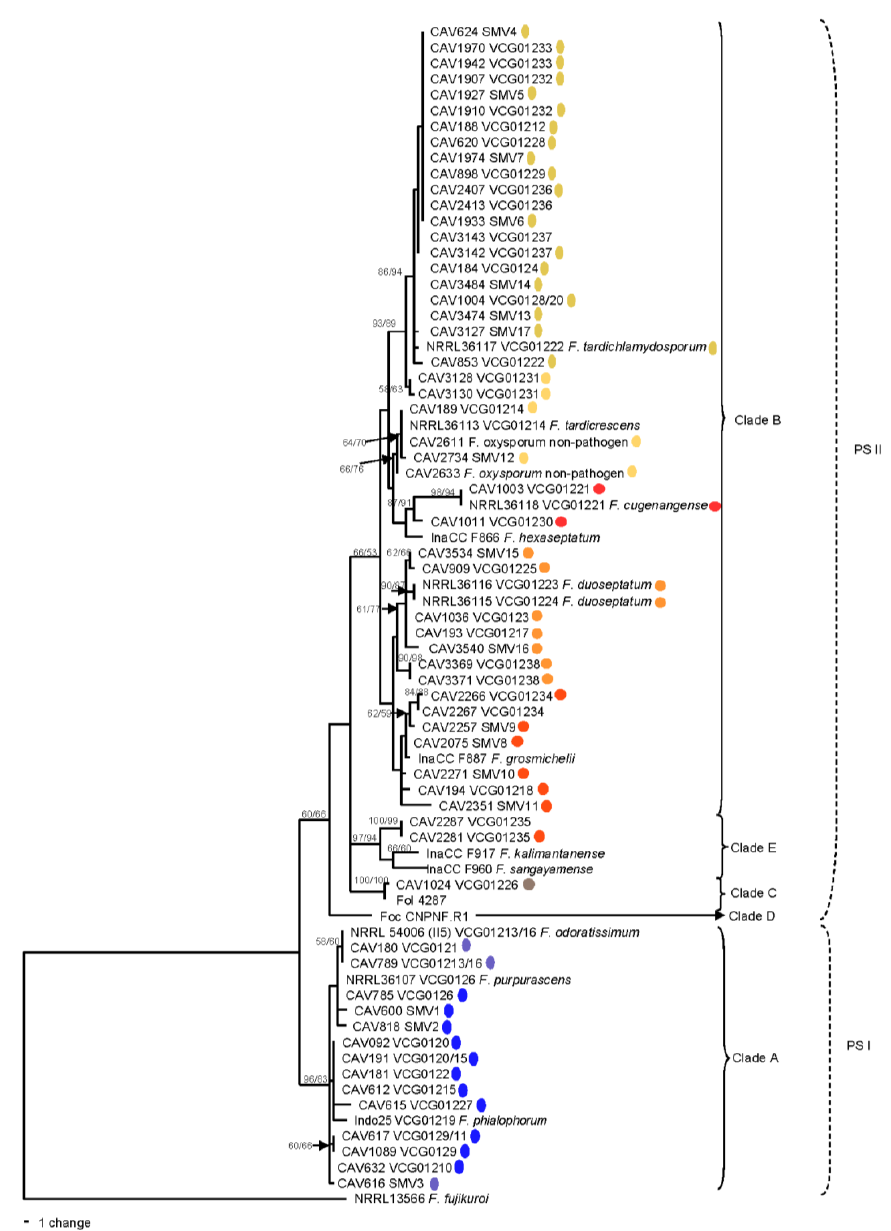
Figure 1. Maximum parsimony tree inferred from the combined data sets of the rpb1 , rpb2 and tef1 gene regions for Fusarium oxysporum f. sp. cubense isolates. Bootstrap values generated from the maximum parsimony, followed by maxi- mum likelihood analysis (>60%), are shown at the internodes. Clade designation (A –E) is according to O’Donnell et al. [40], while the phylogenetic species boundary sensu Laurence et al. [23] is indicated (PS I and PS II). Culture collection number, Vegetative compatibility group (VCG) or single member VCG, are indicated on tips. Snapclust (SC) grouping is indicated in different colours. The tree is rooted with F. fujukuroi NRRL 13566.